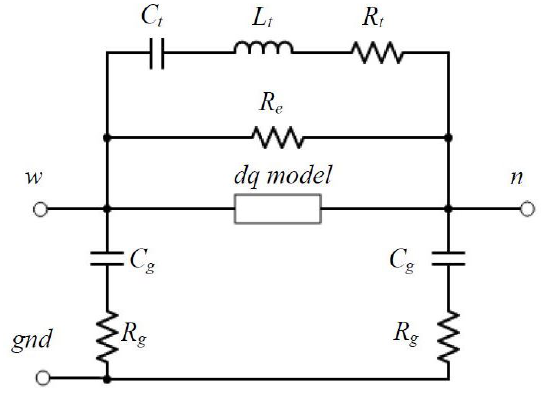
Figure 13. HF phase circuit proposed in